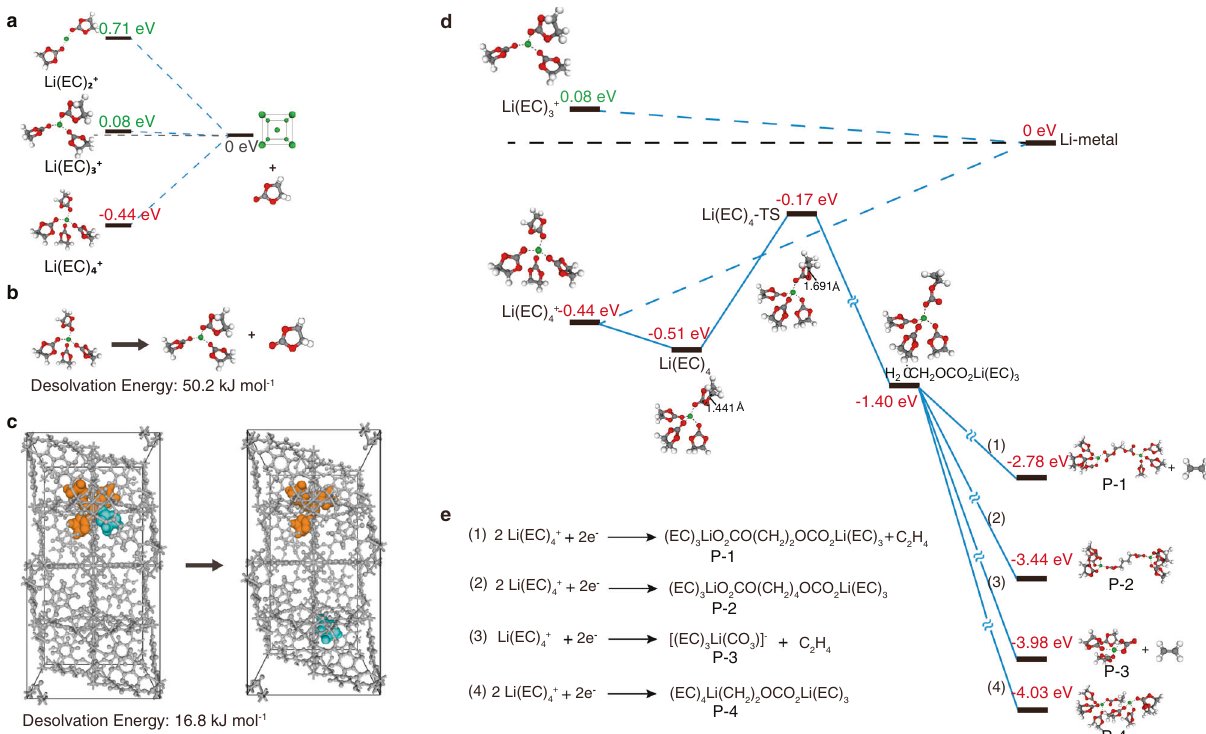
Fig. 5 Density functional theory calculated energy pro fi le for the reduction process of Li + -solvates. a Reduction energy of Li + -solvates Li(EC) 4 + and partially desolvated species Li(EC) 3 + , Li(EC) 2 + by density functional theory (DFT). b , c Desolvation energy of Li(EC) 4 + to Li(EC) 3 + and EC molecule in liquid electrolyte and UiO-66, respectively. d The reduction process of Li(EC) 4 + and Li(EC) 3 + and reductive decomposition process of Li(EC) 4 + . e Typical Li(EC) 4 + reductive decomposition